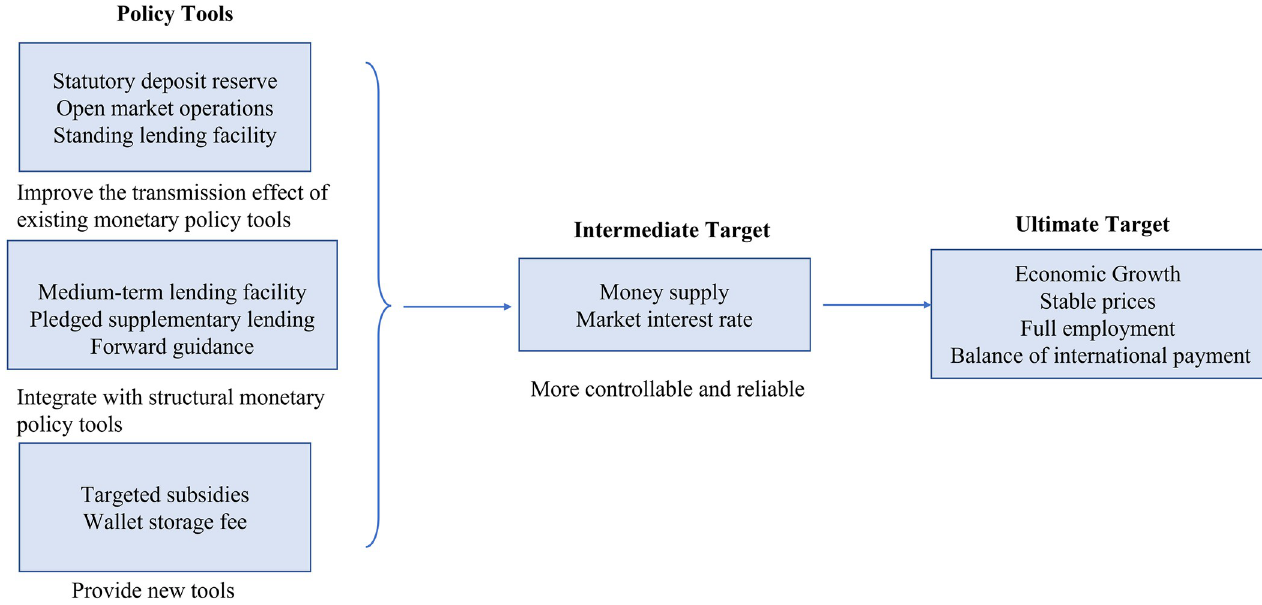
Fig 14. Schematic diagram of the influence of e-CNY on the transmission mechanism of monetary policy.